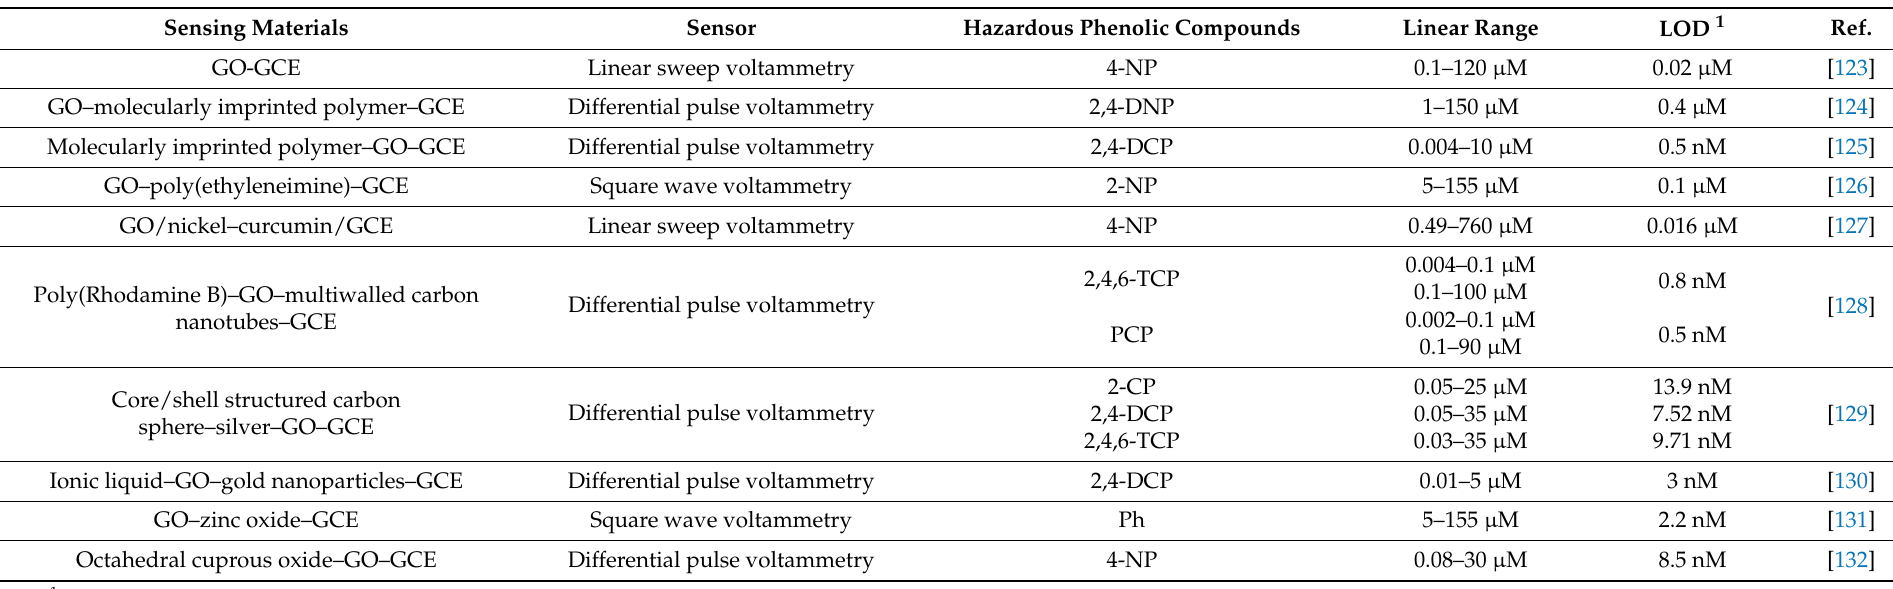
Table 3. GO-based materials incorporated with electrochemical sensors for hazardous phenolic compounds